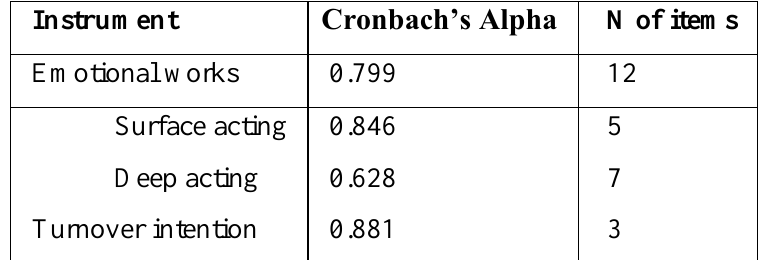
Table 2: Reliability of Construct Measures